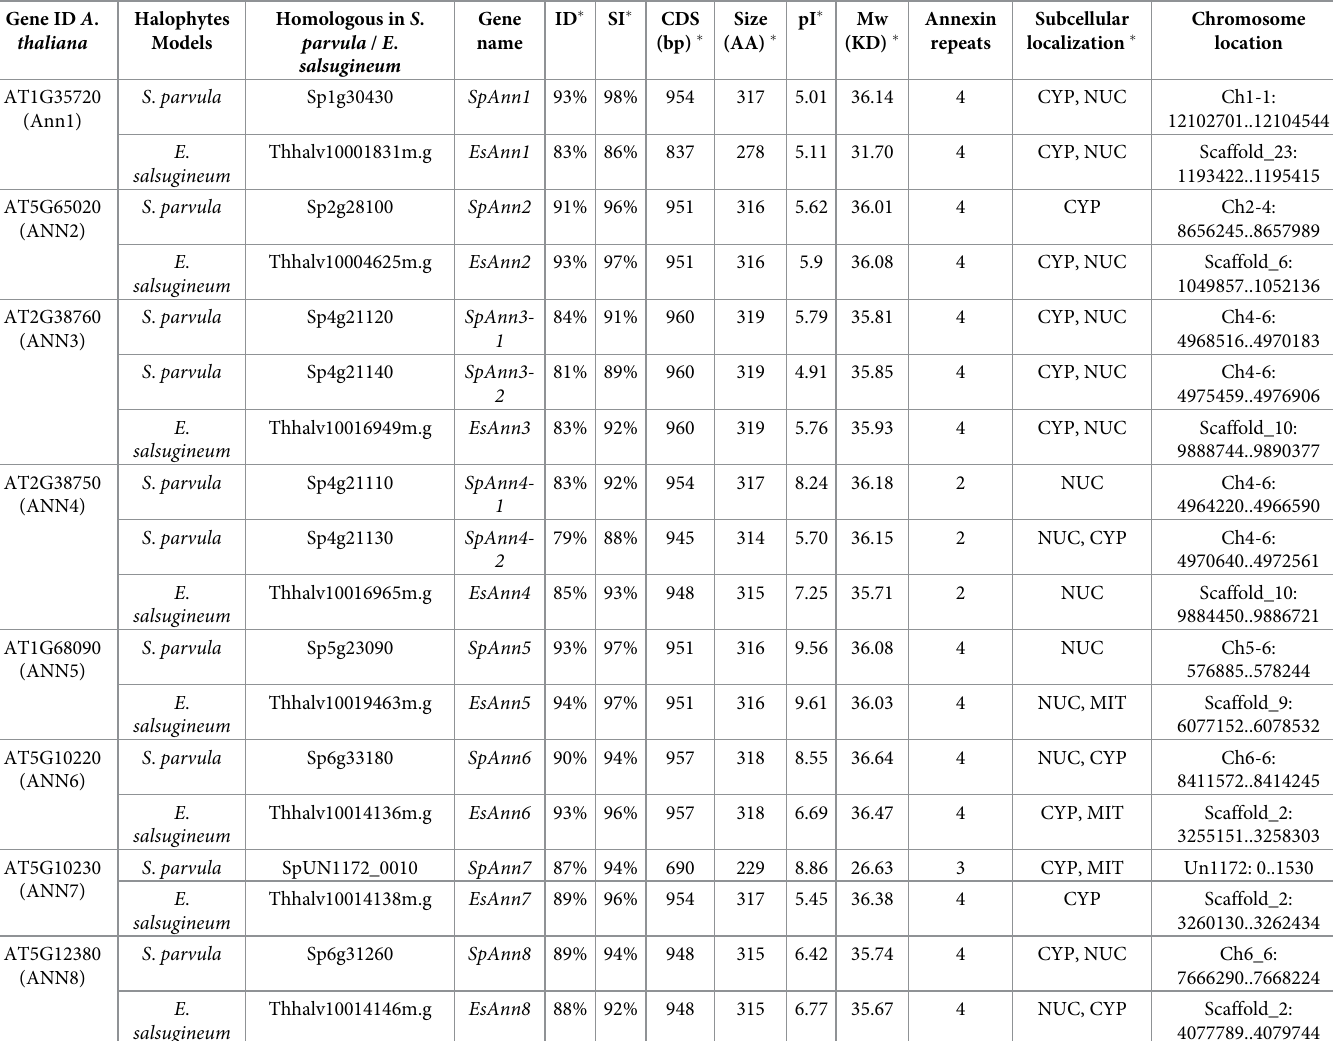
Table 1. List of Ann genes identified in A . thaliana , S . parvula and E . salsugineum . Gene ID A